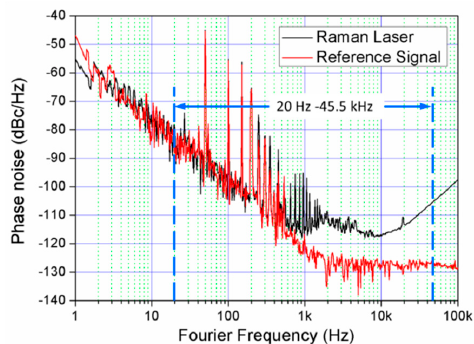
Figure 2. Beatnote between two Raman lasers with a phase noise reduction over 80 dB.